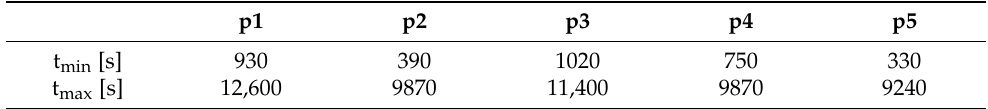
Table 3. Minimum and maximum times for which admissible values of temperature and HTC error on the cylinder boundary were obtained for processes p1–p5.